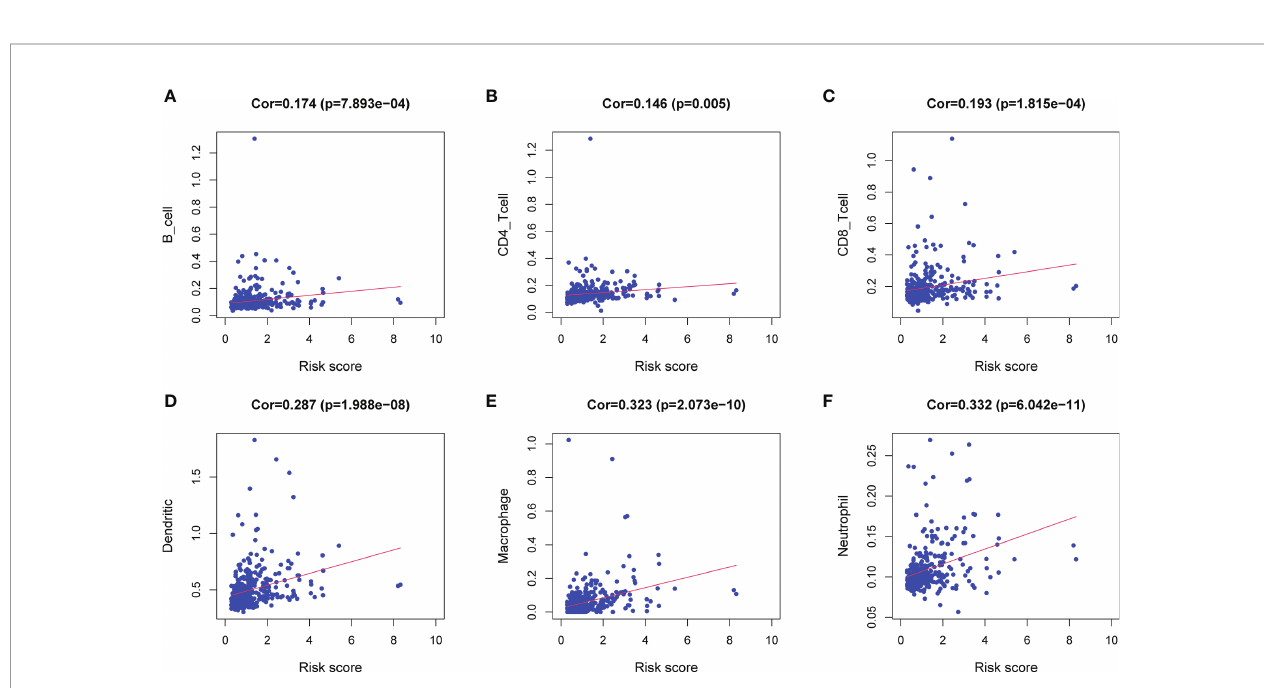
FIGURE 7 | Correlation analysis between the expression of immune microenvironment cells and risk score. There are six types of immune cells involved in the correlation analysis, including B cells (A), CD4 + T cells (B), CD8 + T cells (C), dendritic cells (D), macrophages (E), and neutrophils (F) .